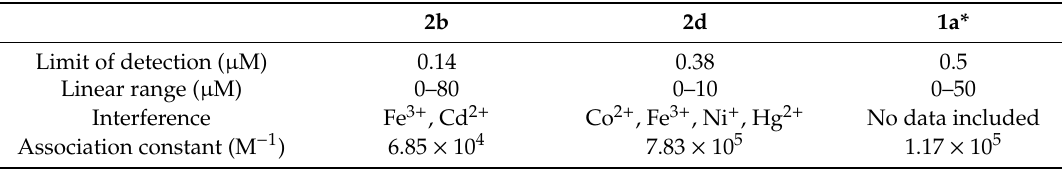
Table 2. A comparison of sensing properties among 2b , 2d , and